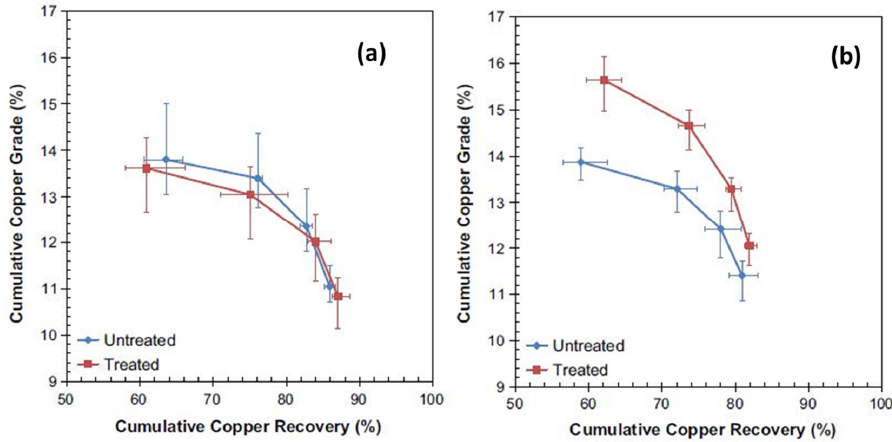
Figure 29. Copper-grade recovery curves for ( a ) fine-grained and ( b ) coarse grained materials under untreated and microwave-treated condition [160].